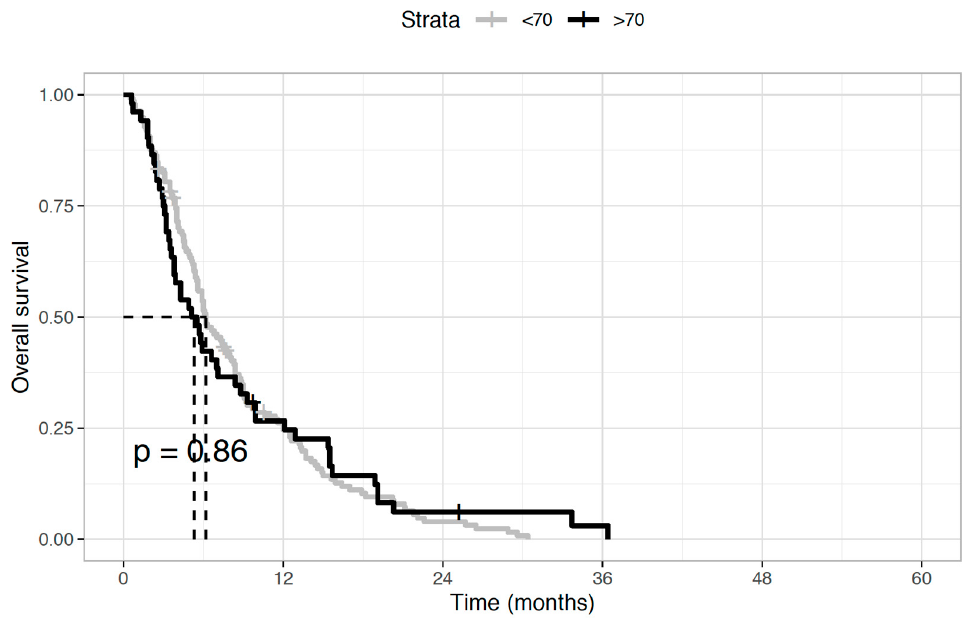
Figure 1. Overall survival (OS) of biliary tract cancer patients receiving second ‐ line chemotherapy. Median OS was 5.7 months in elderly patients and 6.1 months in younger patients (Hazard Ratio 0.97; p = 0.86).